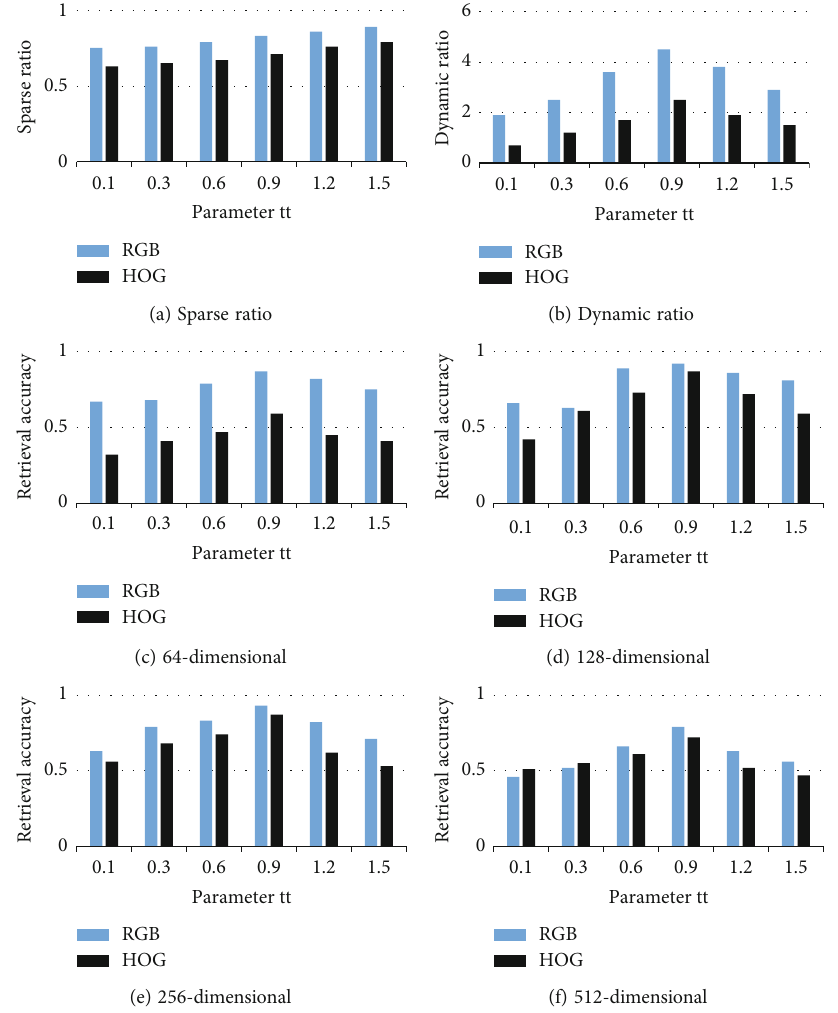
Figure 5: Experimental results under di ff erent parameters